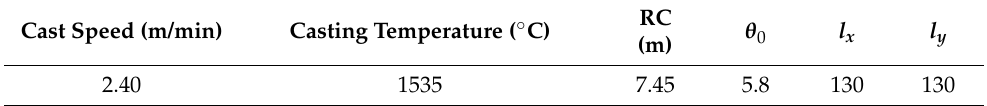
Table 1. Casting conditions.